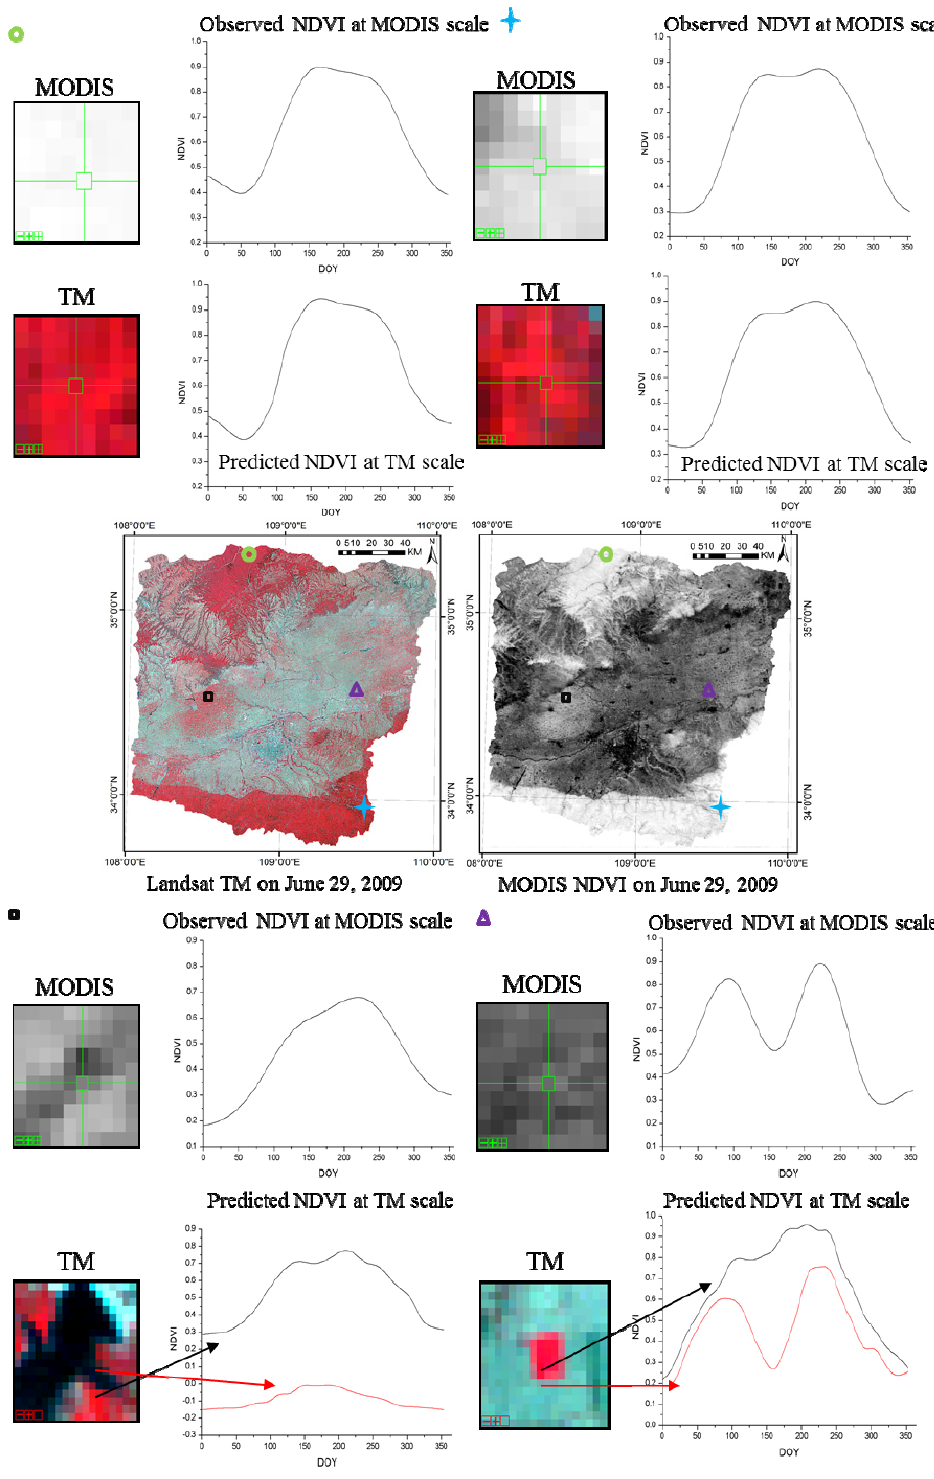
Figure 13. The comparison of the predicted NDVI curves and the observed MODIS NDVI curves for pure MODIS pixels and mixed MODIS pixels. As an example, the upper portion shows the pure MODIS pixels’ curve groups and the lower part shows the mixed MODIS pixels’ curve